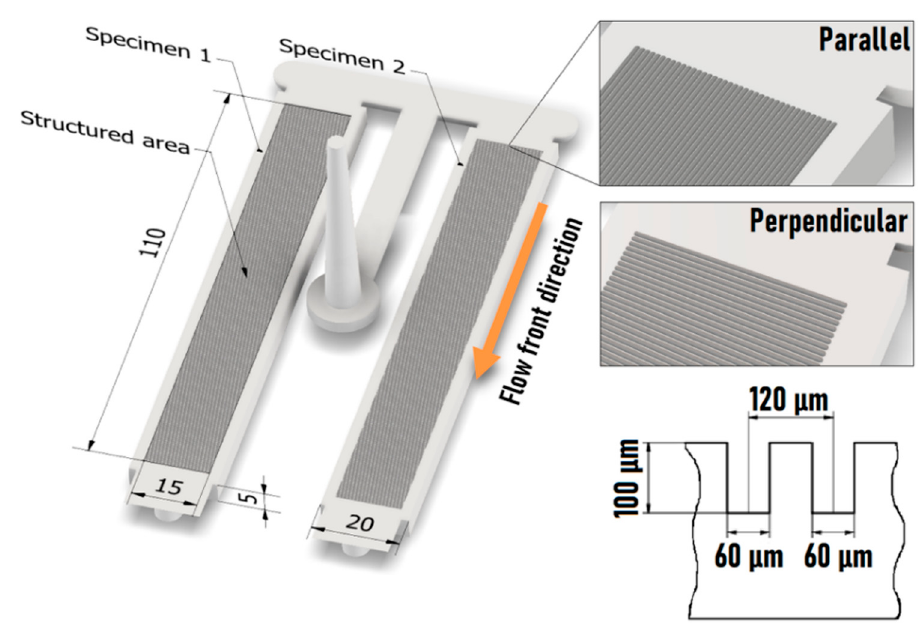
Figure 2. The molded products with microstructured surfaces and the significant dimensions.